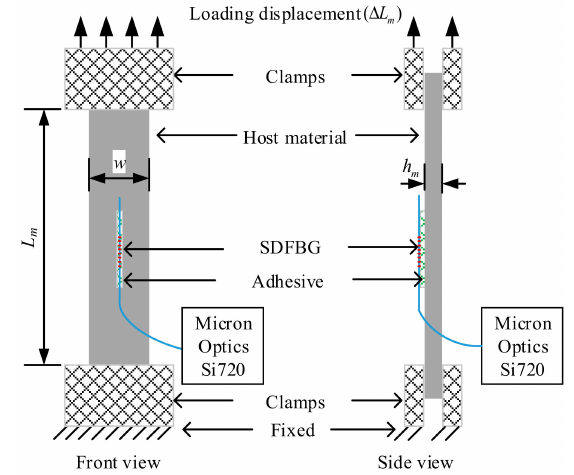
Figure 8. Schematic diagram for strain calibration.